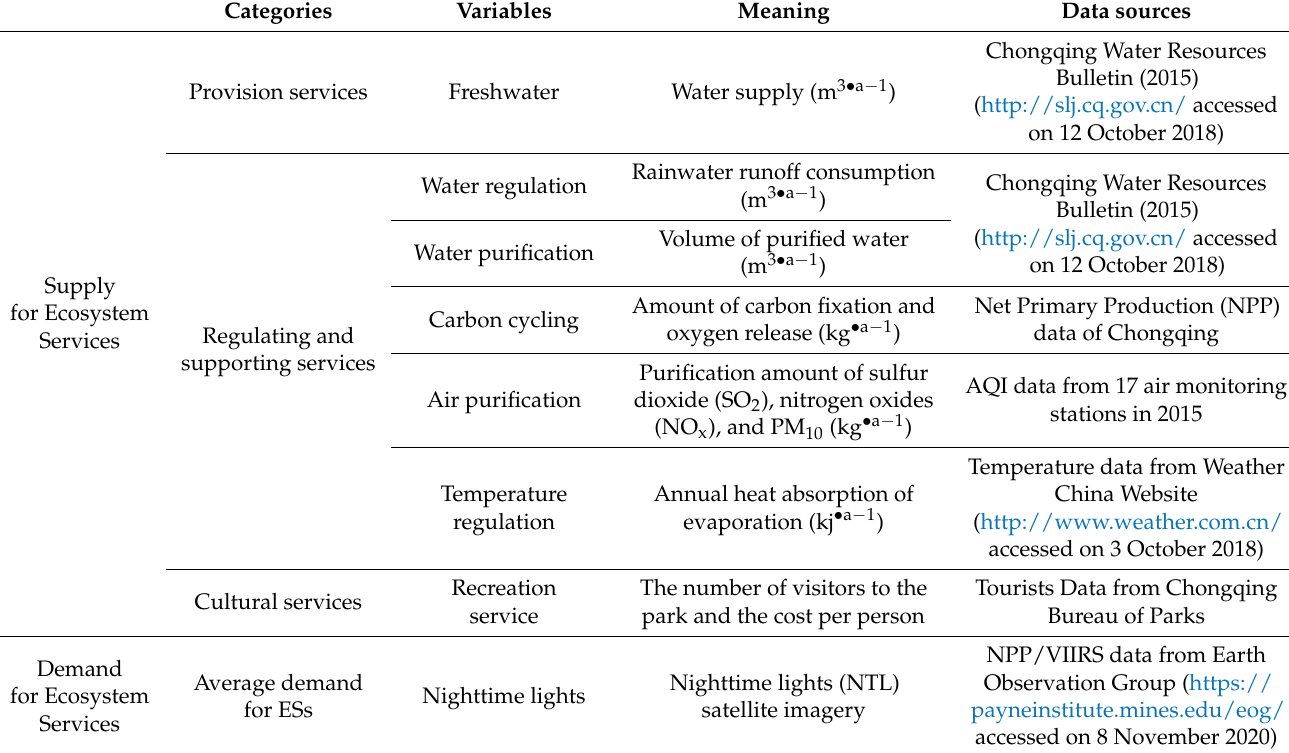
Table 1. Indicators and data